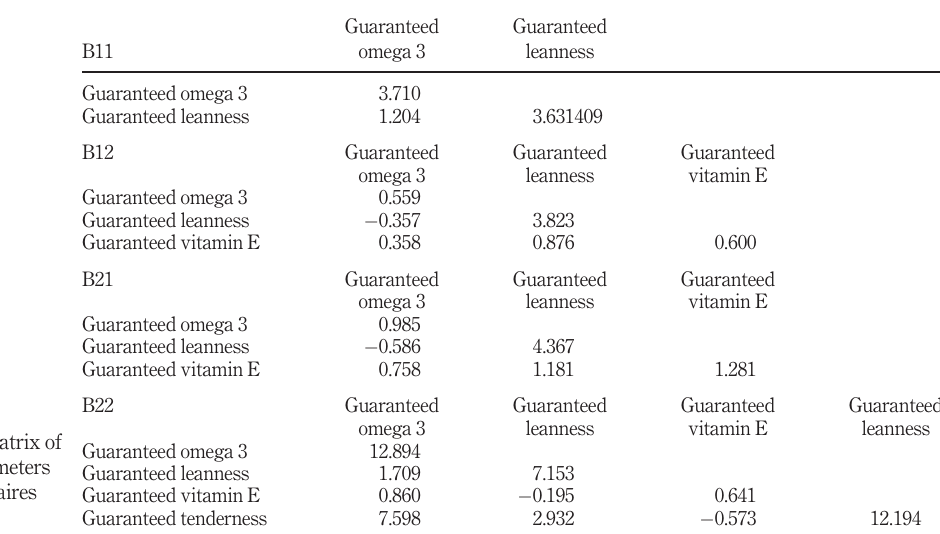
Table 4. Covariance matrix of random parameters for questionnaires A12 and A23